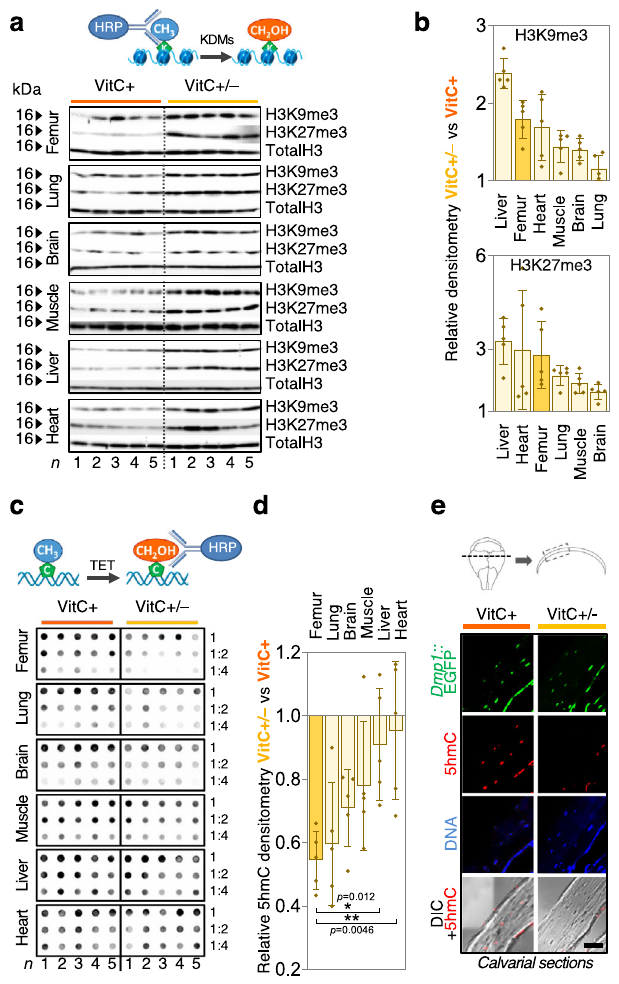
Fig. 2|HistoneandDNAdemethylationsignaturesinbonearehighly sensitive to Vitamin C. a H3K9me3 and H3K27me3 western blots in indicated tissues from 20weekold Gulo – / – micesupplemented with VitC (VitC+) or without VitC from WK 15 to WK 20 (VitC ±). b Relative western blot quantitation to ( a ) shown as fold change to VitC+. c 5hmC dot blot in indicated tissues from same experimental setup as in a and relative quantitation ( d ). e Immuno fl uorescence of 5hmC in cal- varial sections; Gulo − / − mice were crossed with transgenic Dmp1 -EGFP Topaz mice to visualize osteocytes; DIC, differential interference contrast, scale bar represents 50 µ m. Bar graph represent mean±SD; * p <0.05; ** p <0.01; one-way ANOVA with Dunnett ’ s multiple comparison tests ( d ); N =5 per tissue and group from biologi- cally independent animals ( b , d ). Source data are provided as a Source Data